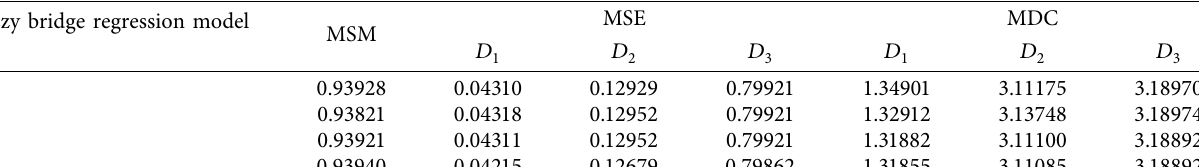
Table 2: Performance measures of the proposed fuzzy bridge regression model to the 15 th simulated dataset with different values of c in Example 1.